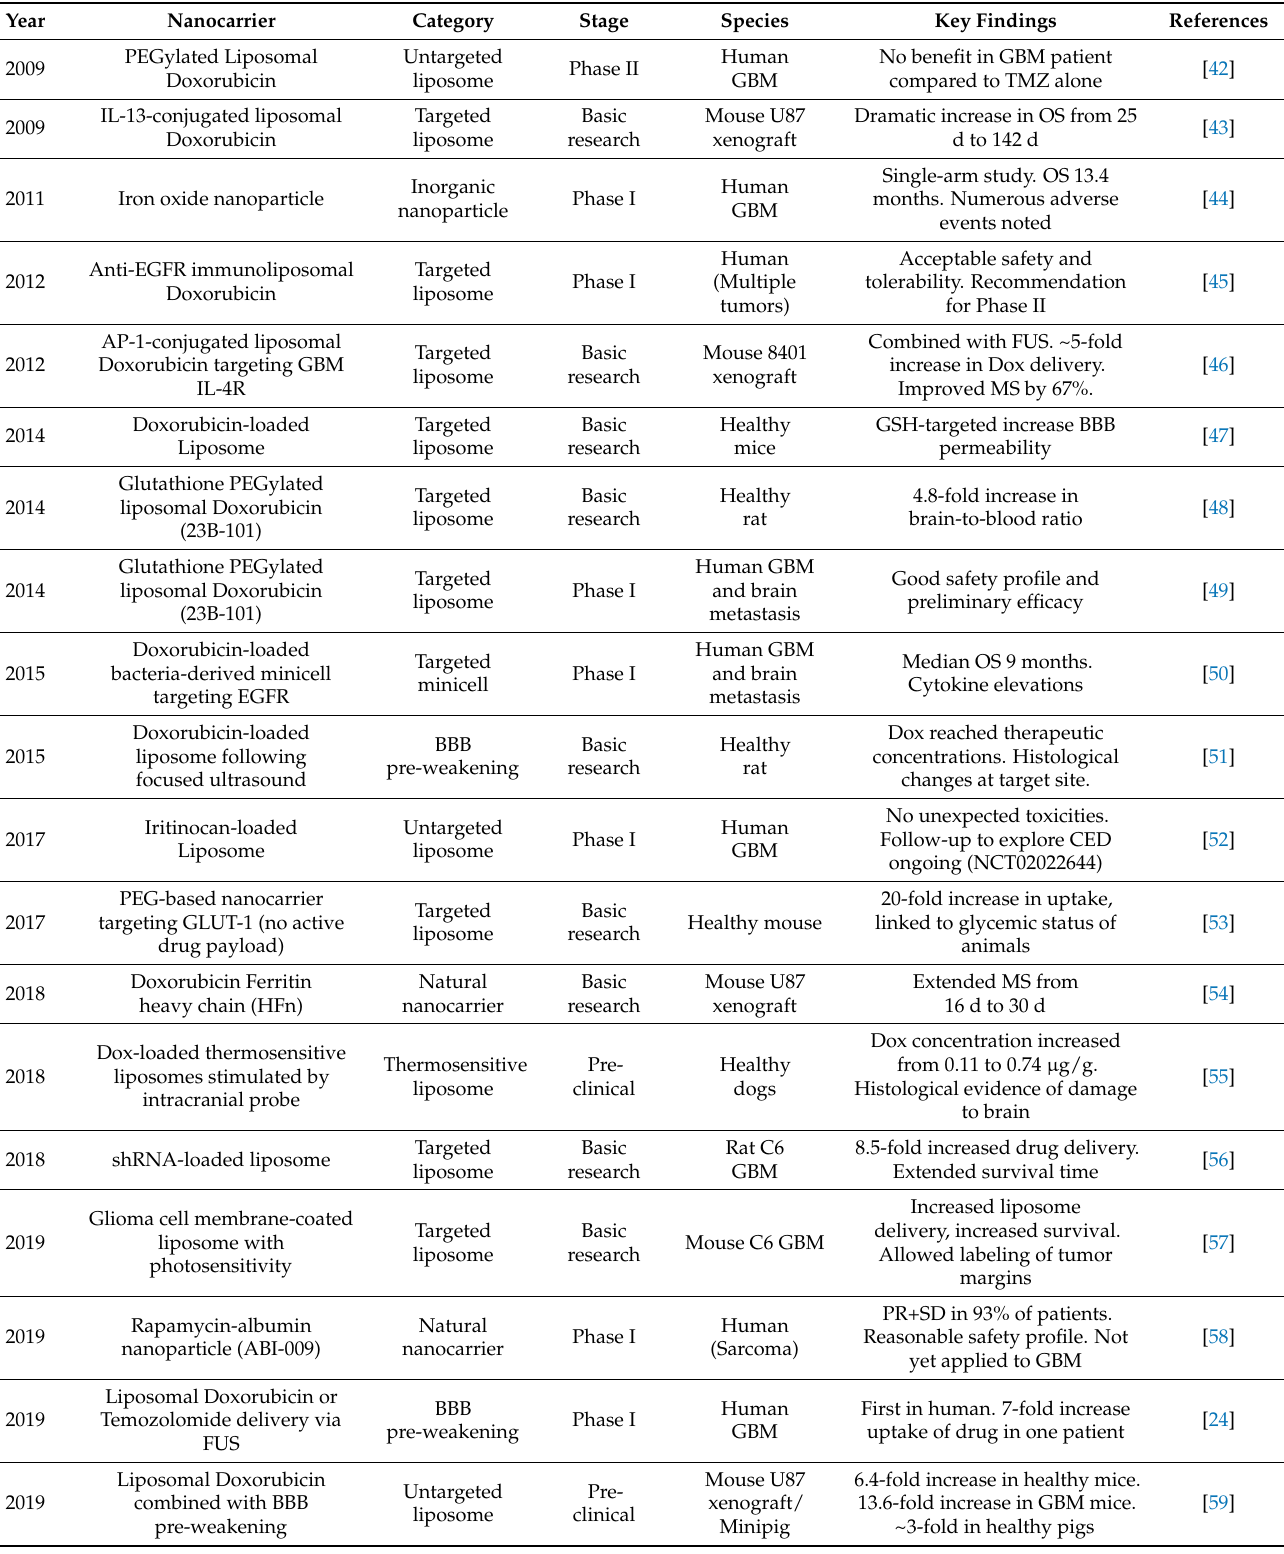
Table 1. Key Studies in the Field of Nanocarrier-based Brain Tumor